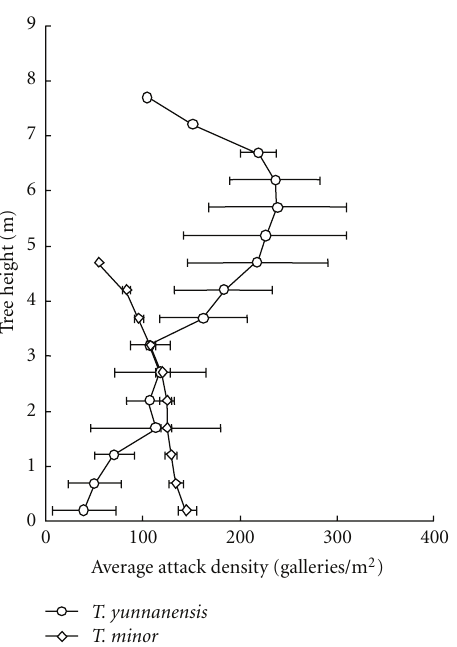
Figure 2: Average attack (egg gallery) density ( ± SE) and distribu- tion of T. yunnanensis and T. minor along the trunks of Yunnan pines in December, 2005 (Qujing, Yunnan province, China). collected and distinguished with a binocular